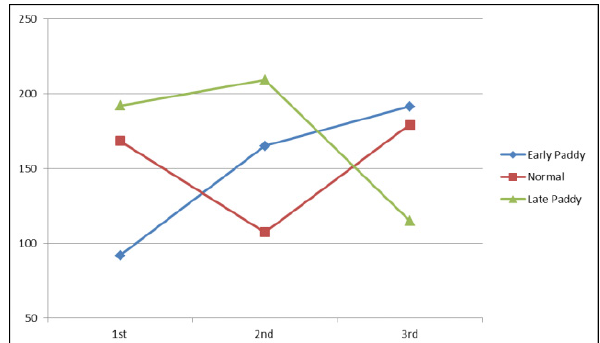
Figure 7: Paddy signatures as obtained from multi-temporal RISAT-1 dataset (scaled values to 255) 2016, Assam.